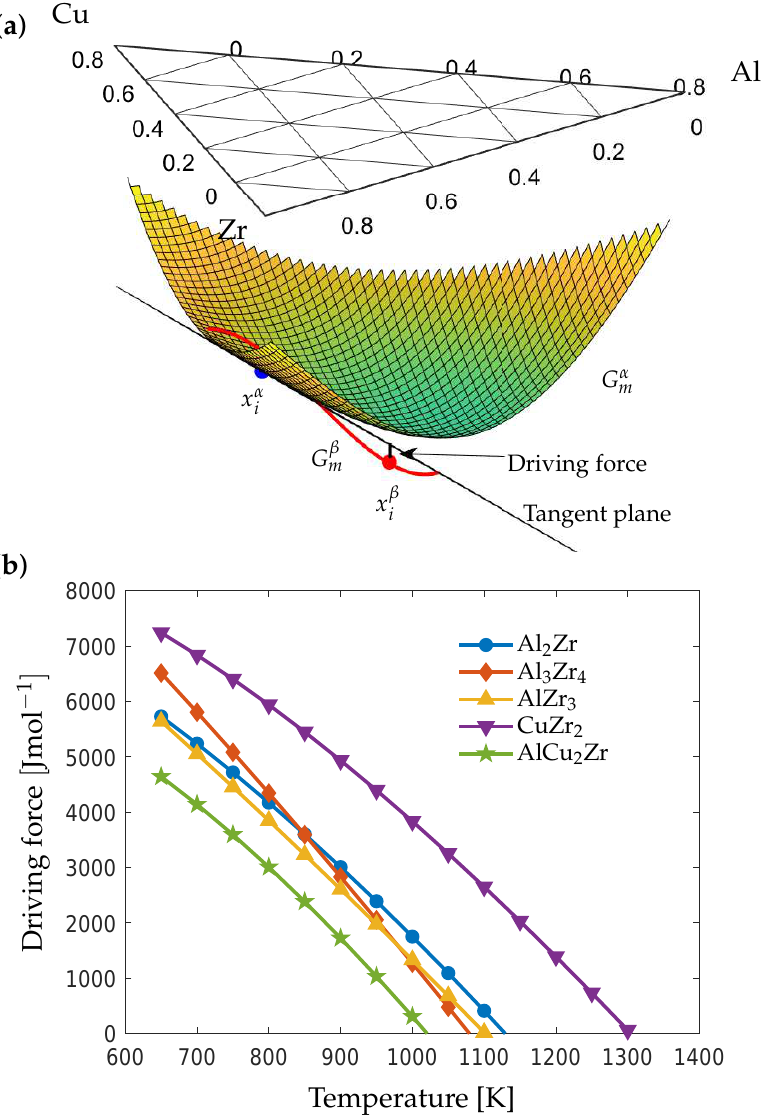
Figure 1. (a) Gibbs energy curves and the chemical driving force d c of the Al 3 Zr 4 phase at T = 800 K (Computed using Eq. (4)). (b) Intermetallic phases with the highest chemical driving force d c in Al 10 Cu 30 Zr 60 at low temperatures.